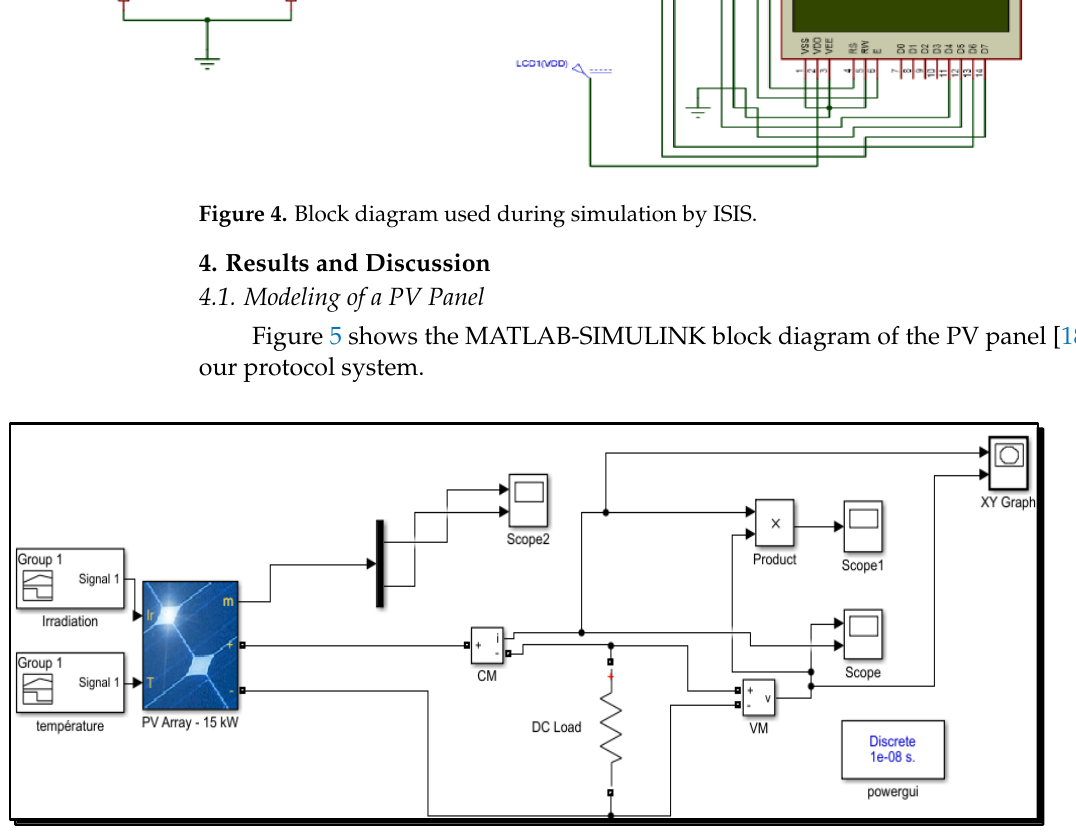
Figure 5. MATLAB ‐ SIMULINK block diagram of a PV panel. Figure 5. MATLAB-SIMULINK block diagram of a PV